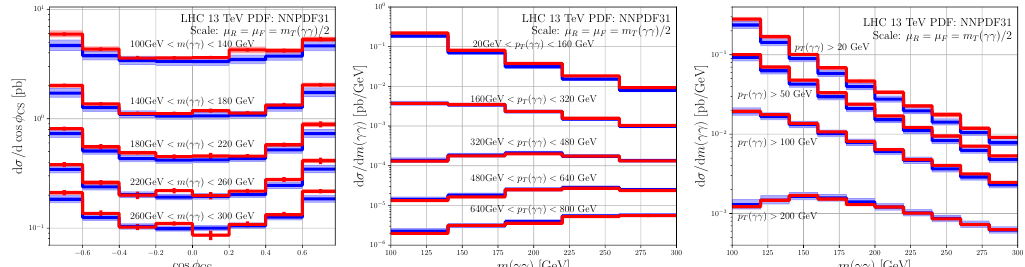
Figure 5 . Two-dimensional differential distributions: in φ CS ⊗ m ( γγ ) (left) and in m ( γγ ) ⊗ p T ( γγ ) but shown in two alternative forms and for different choice of bins: in p with p ( γγ ) cuts (right). Only the NLO and NNLO central scale predictions and scale variation T bands are shown. Note that the figure to the right shows the same results that already appear in figures 1,